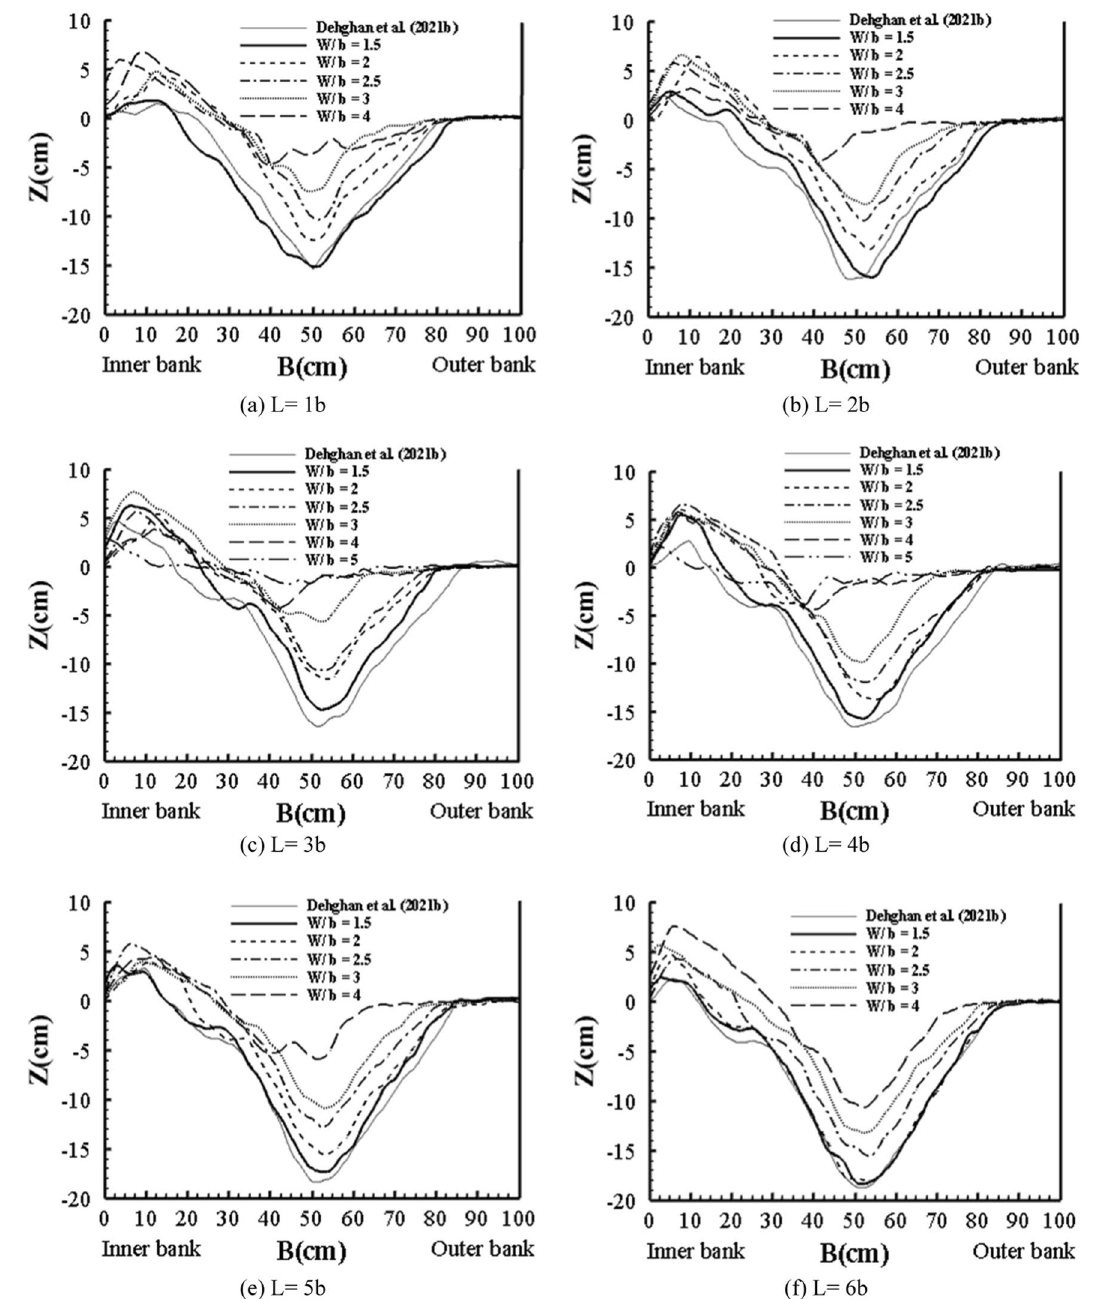
Fig. 8 Sample of the transverse sections near the nose of combination of pier and collar installed at the 90-degree